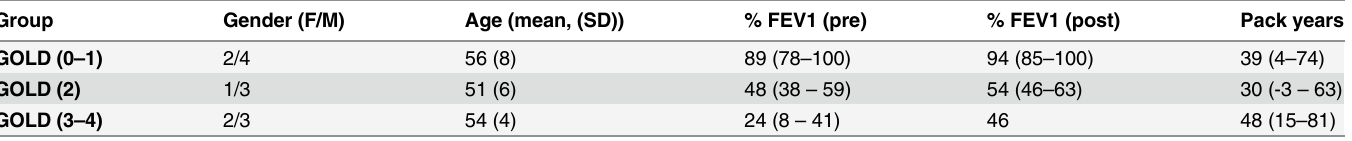
Table 1. Patient demographics of COPD